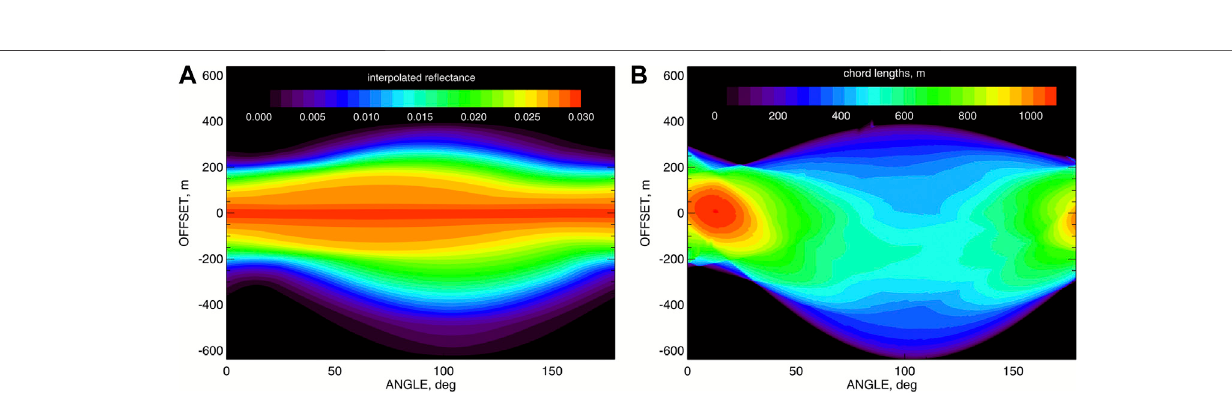
Frontiers in Remote Sensing |